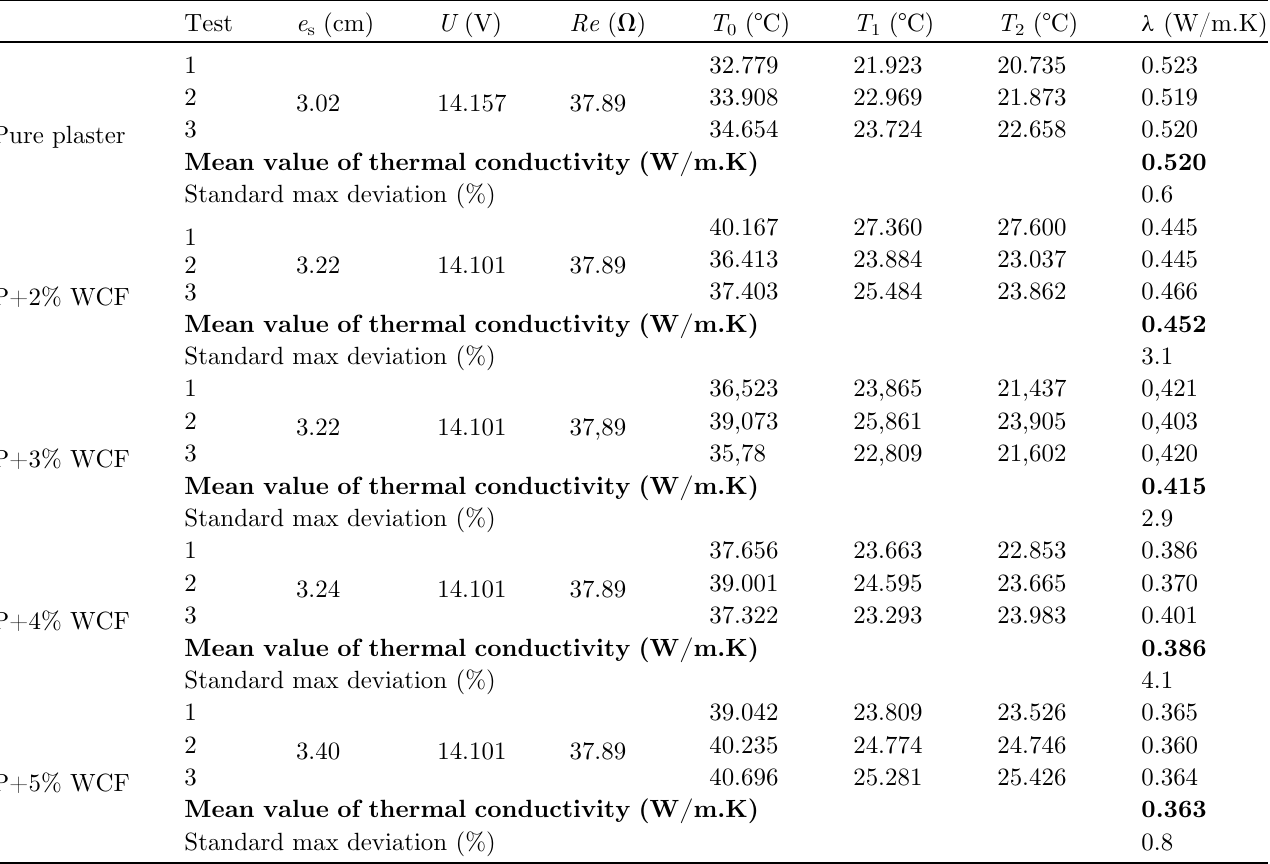
Table 1. Measurement input data and experimental results for the thermal conductivity of various